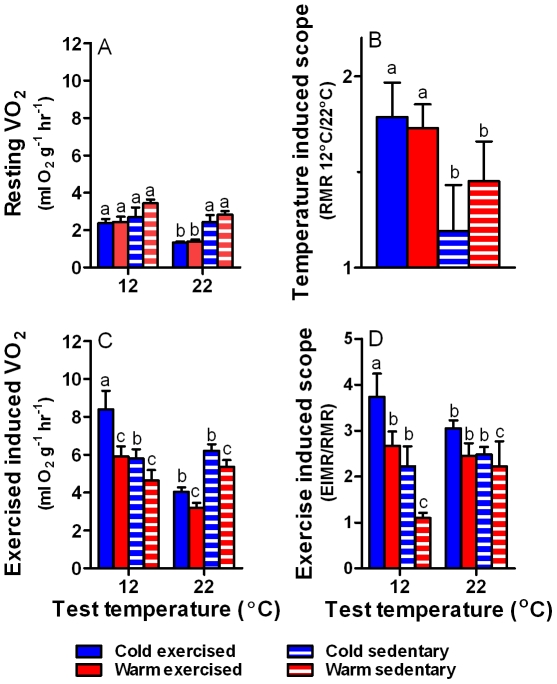
Oxygen consumption and metabolic scopes of cold and warm acclimated sedentary and exercised rats.Resting (RMR; A) and exercise induced (EIMR; C) metabolic rates (ml O2.g−1.hr−1) in cold exercised (blue bars), warm exercised (red bars), cold sedentary (blue hatched bars) and warm sedentary (red hatched bars) rats (mean ± s.e.m) measured at different ambient test temperatures (12°C and 22°C). Resting metabolic rates (A) were lowest in exercised animals at 22°C, and exercised induced metabolic rates (C) were highest in cold acclimated exercised rats. Temperature induced metabolic scope (RMR at 12°C/RMR at 22°C; B) was greatest in exercised rats, and exercise induced metabolic scope (EIMR/RMR; D) was greatest in cold acclimated exercised rats at 12°C. Letters above columns indicate significant differences; please note however that there were also significant interactions which are difficult to represent graphically.